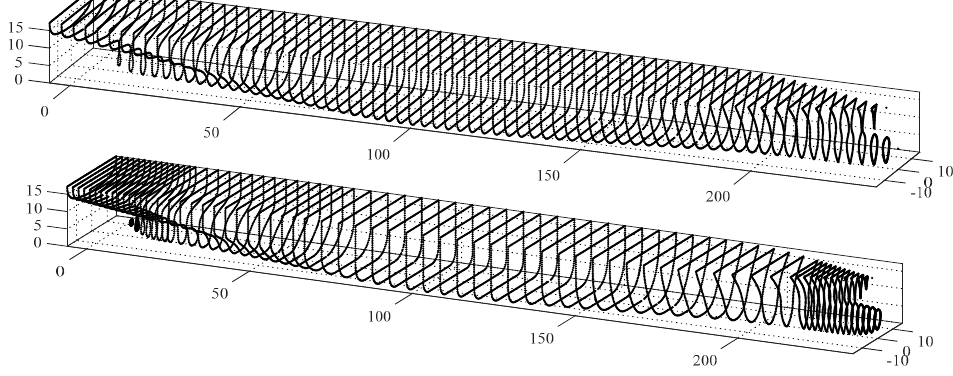
Figure 7. Uniform and non-uniform slicing (KCS, 70 slices, Top: uniform; Bottom: non-uniform).